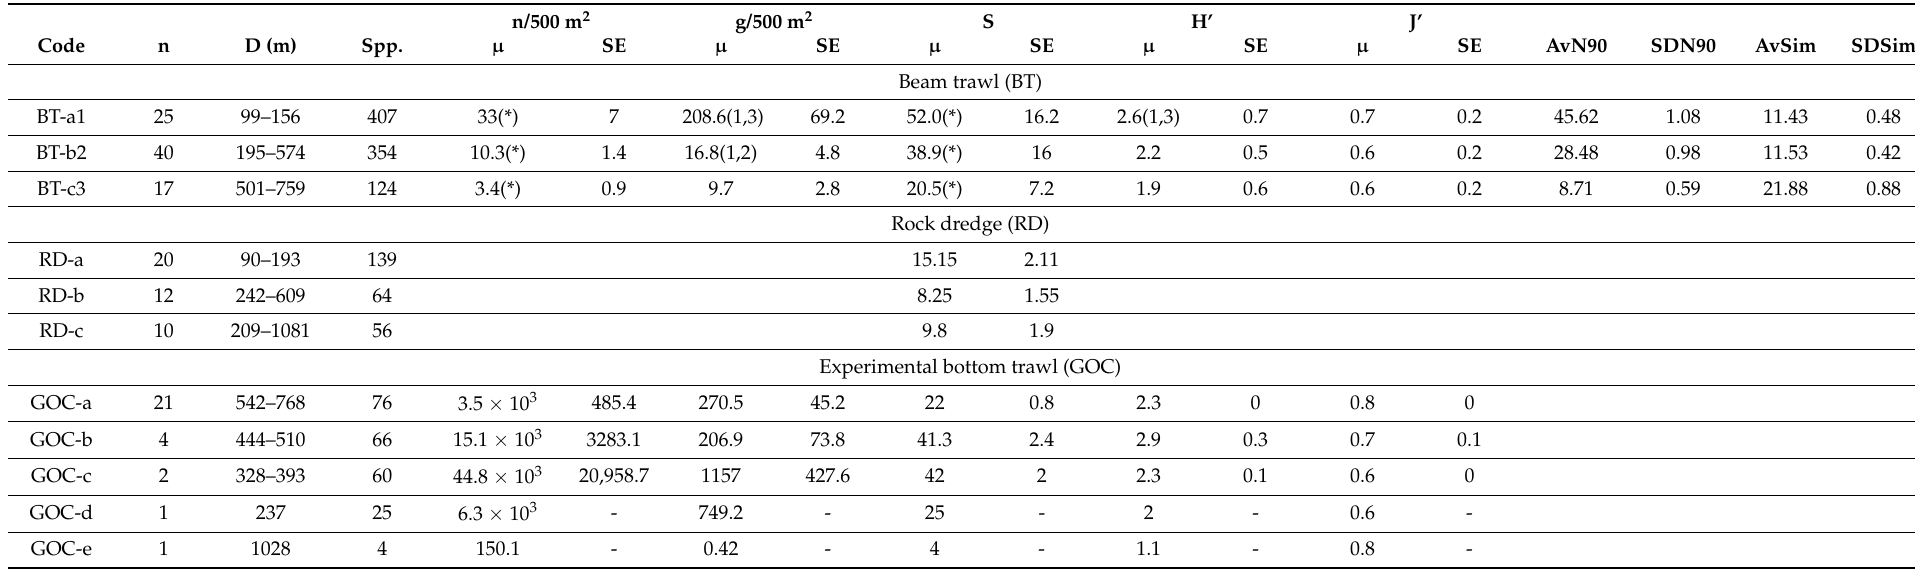
Table 2. Mean values ( µ ) and standard errors (SE) of standardized abundance and biomass, species richness (S), Shannon–Wiener (H’), and Pielou evenness (J’), estimated for each of the assemblages identified from multi-variant analysis of beam trawl, rock dredge, and experimental bottom trawl samples obtained at the Ses Olives, Ausias March, and Emile Baudot seamounts and adjacent area of the Mallorca Channel (Balearic Islands, western Mediterranean). The code (see Figure 7), number of samples analyzed (n), depth (D), number of species (Spp.) of each assemblage, and the significant differences (Kruskal–Wallis test; p < 0.001) between all assemblages (*) or between pairs of assemblages (1–2, 1–3) are also shown. In the case of beam trawl sample assemblages, mean (AvN 90 ) and standard deviation (SDN 90 ) values of the N90 diversity index are also shown, jointly with the associated average (AvSim) and the standard deviation (SDSim) values of within-group similarity. n/500 m 2 g/500 m 2 S H’ J’